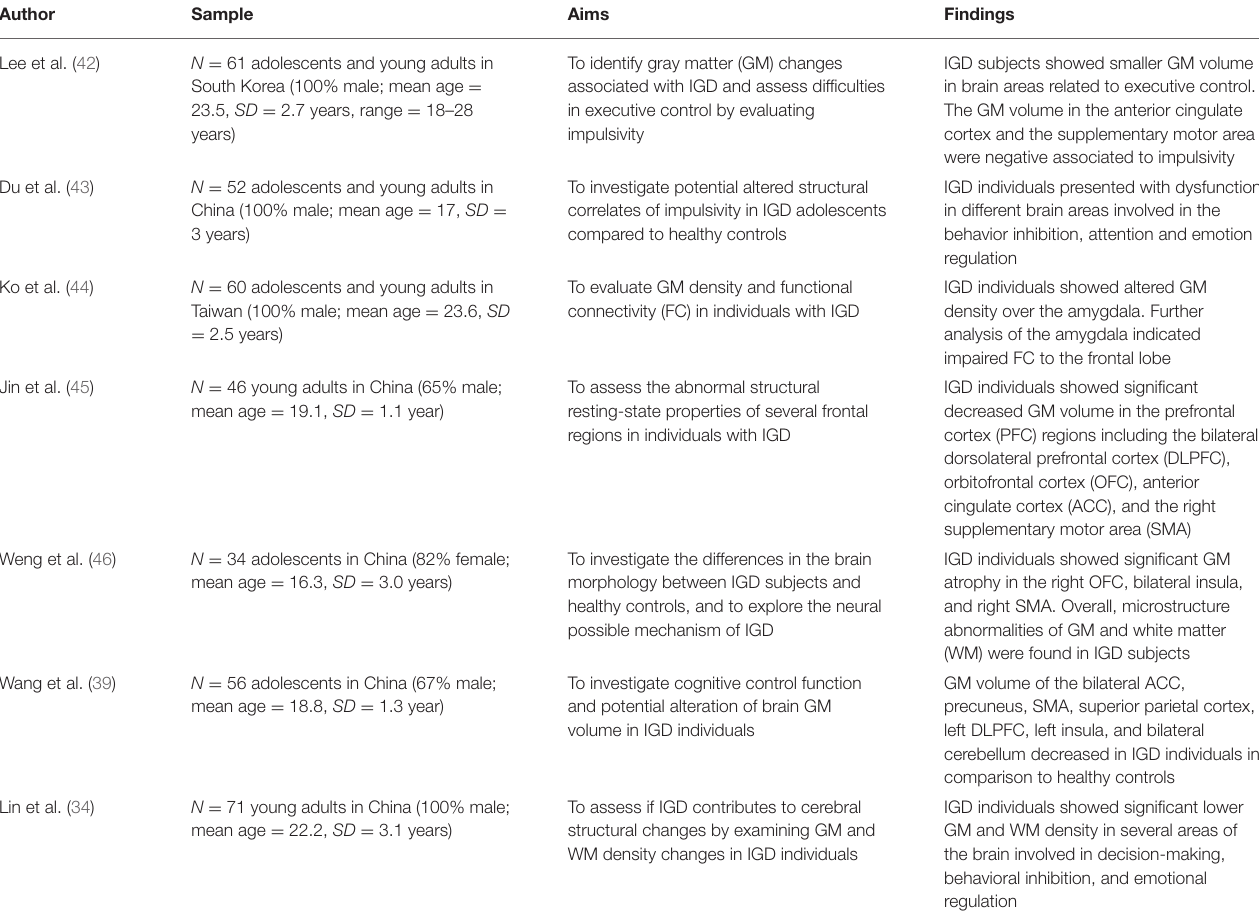
TABLE 3 | Voxel-based morphometry (VBM) studies of Internet Gaming Disorder